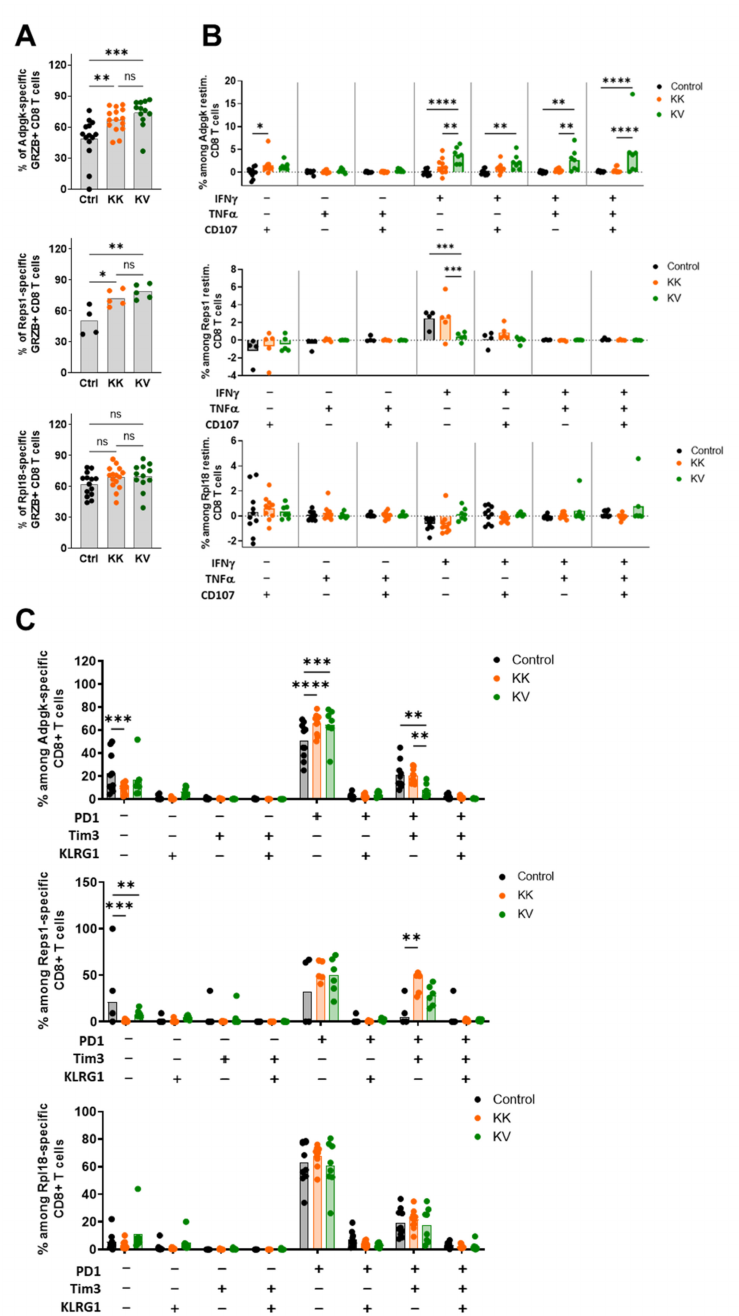
Figure 5. Different functional and exhaustion status among antigen-specific tumor-infiltrating CD8+ T cells in MC-38 tumor-bearing C57BL/6 mice. ( A ) Intracellular Granzyme B positive CD8+ T cells were assessed among tetramer-positive (from top to bottom: Adpgk, Reps1, Rpl18) intratumoral CD8+ T cells. Tumors were harvested on day 18 post-MC-38 tumor implantation. ( B ) Tumor-infiltrating CD8+ T cells were stimulated for 6 h with either Adpgk (upper graph), Reps1 (middle) or Rpl18 (lower graph) peptide and stained for IFN- γ , TNF- α and CD107 α . Tumors were harvested on day 18 post-MC-38 tumor implantation. ( C ) The exhaustion status was examined on tumor-infiltrating tetramer-positive (from top to bottom: Adpgk, Reps1, Rpl18) CD8+ T cells in regard to expression of PD-1, Tim-3 and the effector marker KLRG1. Tumors were harvested on day 18 post-MC-38 tumor implantation. Data in ( A – C ) are shown as means (filled bar) and derived from at least two independent experiments for Adpgk and Rpl18 analysis and one experiment for Reps1. * p < 0.05, ** p < 0.01, *** p < 0.001, **** p < 0.0001. One-Way ANOVA followed by Tukey’s multiple comparison